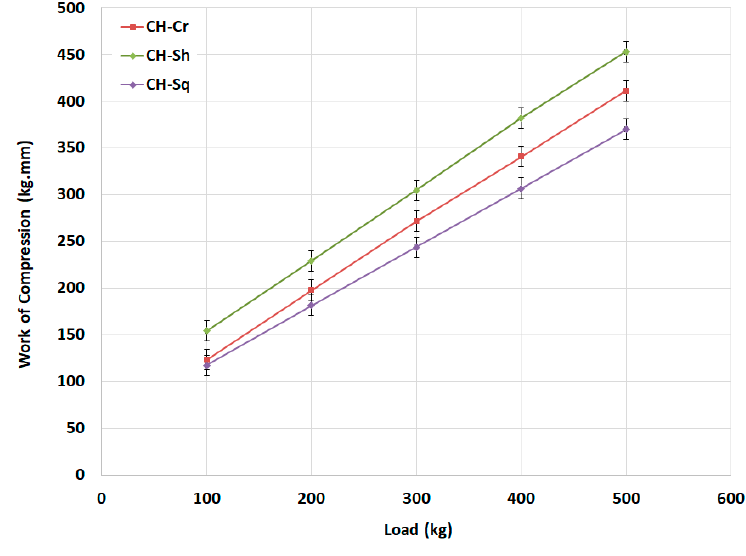
Figure 10. Compression work for CH-Cr, CH-Sh, and CH-Sq CHs.